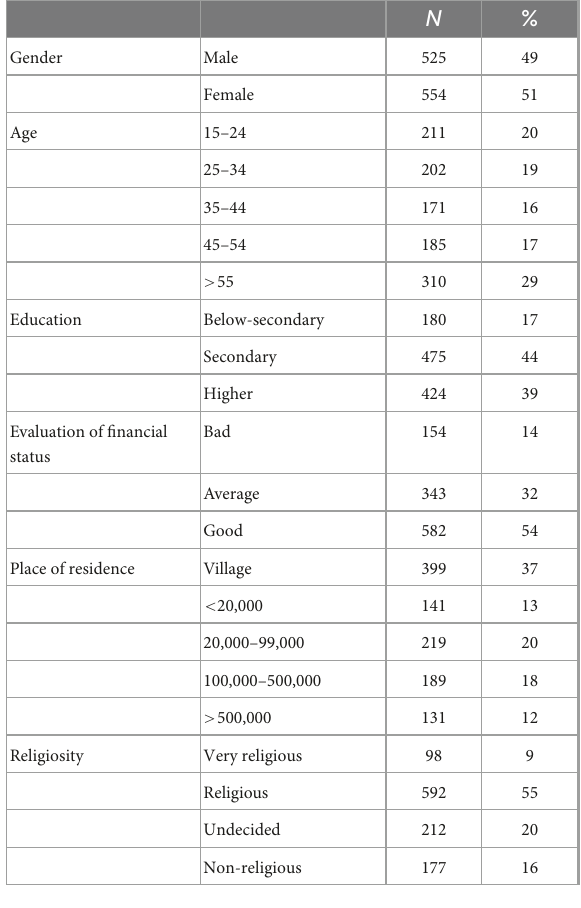
TABLE 1 Frequency ( N ) and percentage (%) of answers to demographic questions.